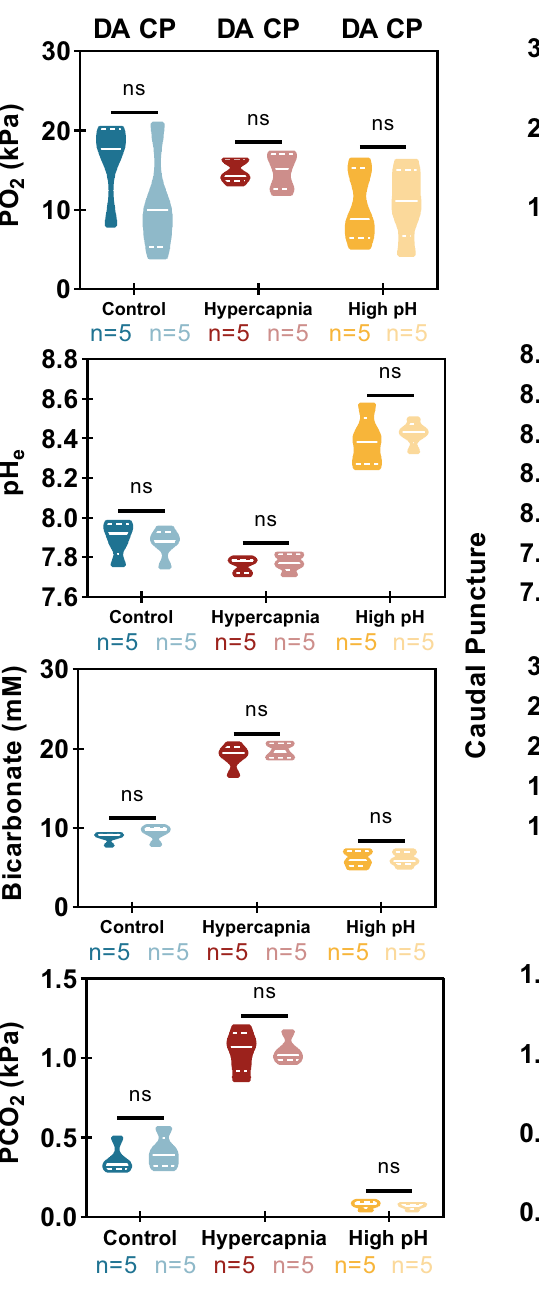
Figure 3. Experiment 2 Effect of three different environmental conditions (control, high CO2 or high pH) on variables of blood sampled either via dorsal aorta cannula (DA, darker violin plots) or paired samples via caudal puncture using in-situ anaesthesia (CP, lighter violin plots). Data are presented as truncated violin plots for each variable versus the three environmental conditions with a solid white line denoting the median and dotted white lines indicating the bounds of the inter-quartile range (IQR) (left panels) or as linear regressions of the caudal puncture versus dorsal aorta sample techniques for each variable (right panels). Significant differences in violin plots are denoted by different letters as determined by a repeated measures design of a partition sum of squares general linear model (GLM) with Šídák’s multiple comparisons tests and alpha defined as 0.05. Linear regressions compared caudal puncture data versus dorsal aorta cannula data (black line ± 95% CI boundaries in black dotted lines) to an equivalence line (red line) where alpha =